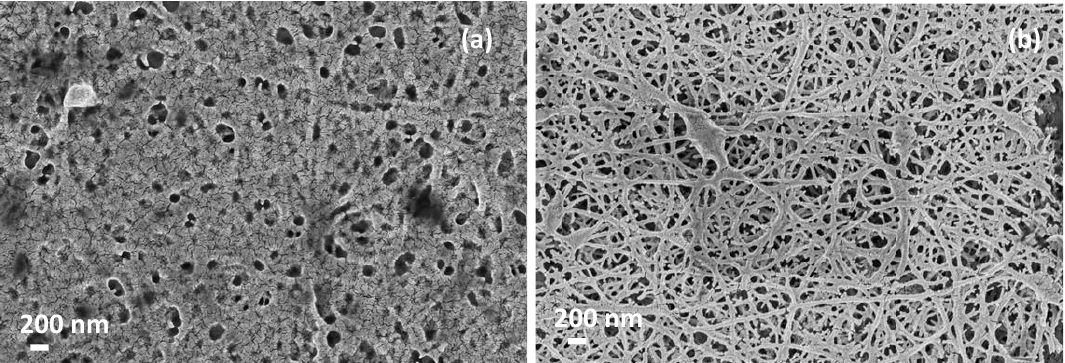
Figure 9. FESEM images of NFs layers after a heat treatment at ( a ) 200 °C for five hours and ( b ) 190 °C for three hours.